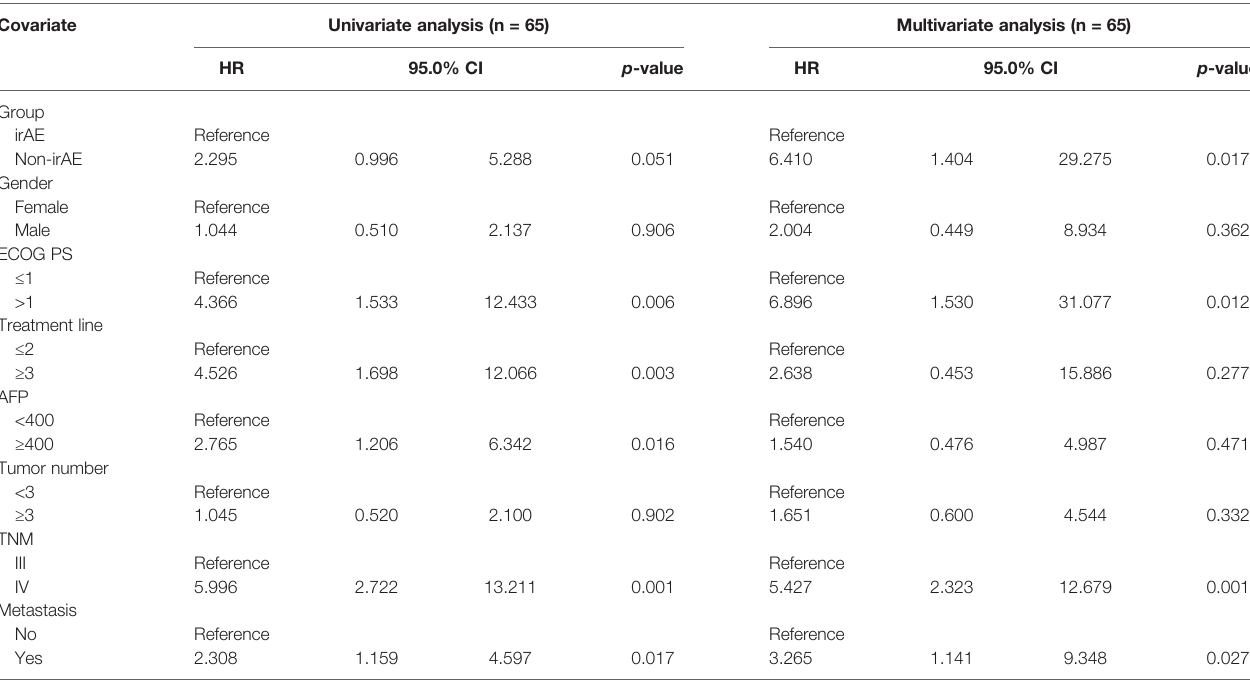
TABLE 4 | Univariate and multivariate analyses of OS with Cox regression models.